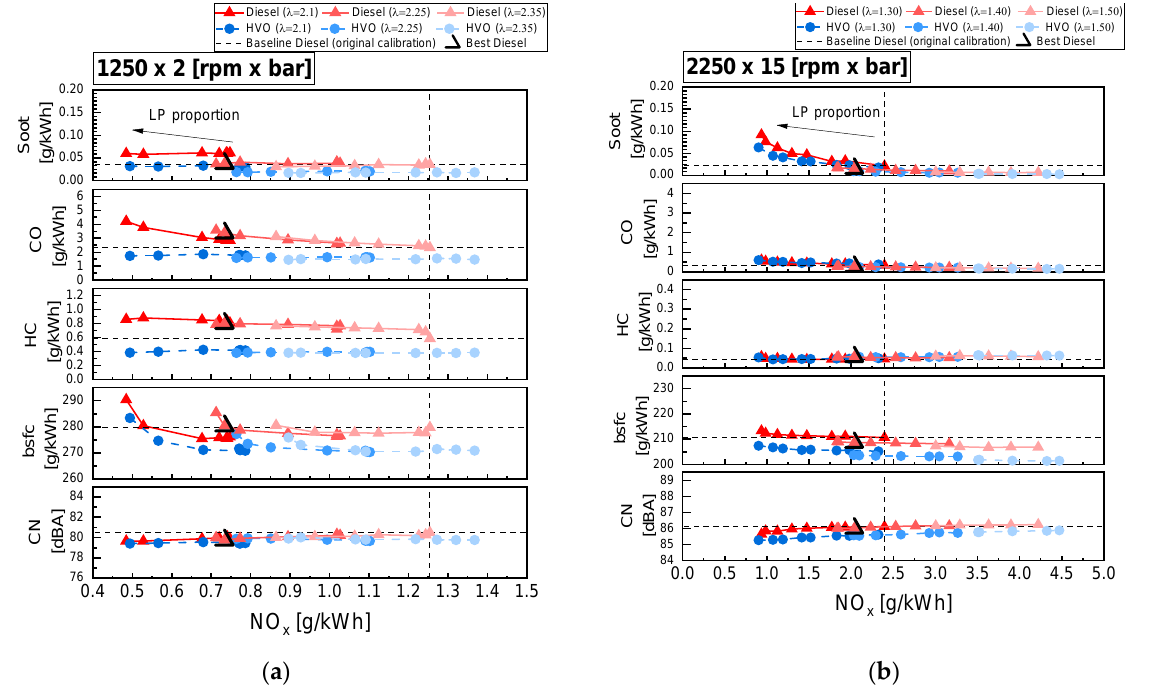
Figure 3. Emissions, fuel consumption and combustion noise for diesel and HVO at 1250 × 2 ( a ) and 2250 × 15 ( b ). Results along EGR split sweeps at several fixed λ values.